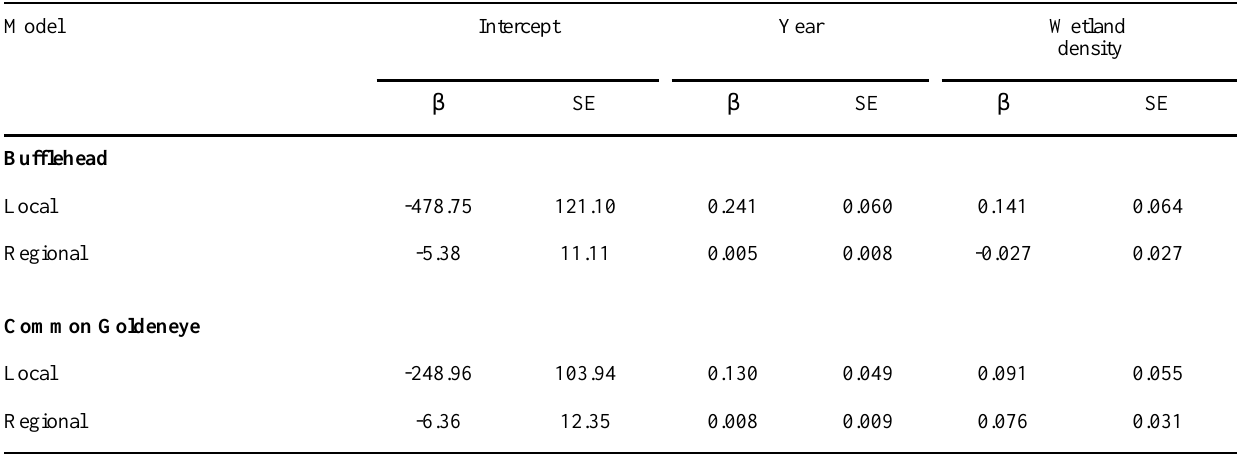
Table 3. Model-averaged parameter estimates and unconditional standard error modeling densities of Common Goldeneye ( Bucephala clangula ) and Bufflehead ( Bucephala albeola ) nesting pairs for local and regional scales. SE = standard